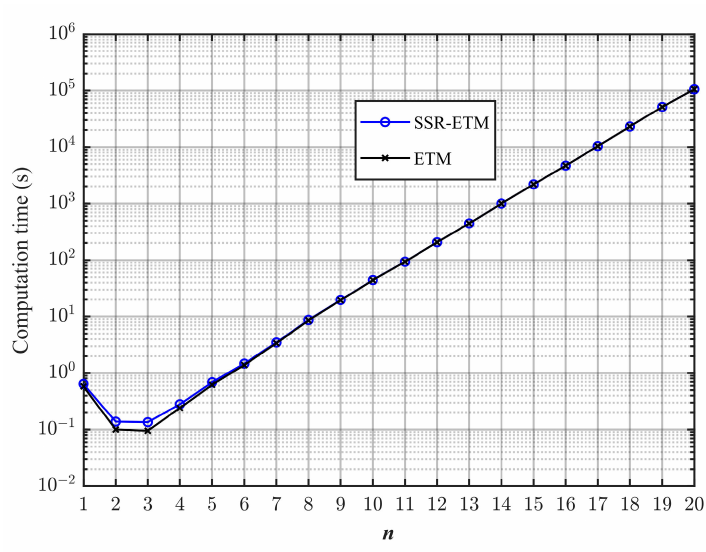
Figure 3. Computation time of the two methods for the non-monotonic